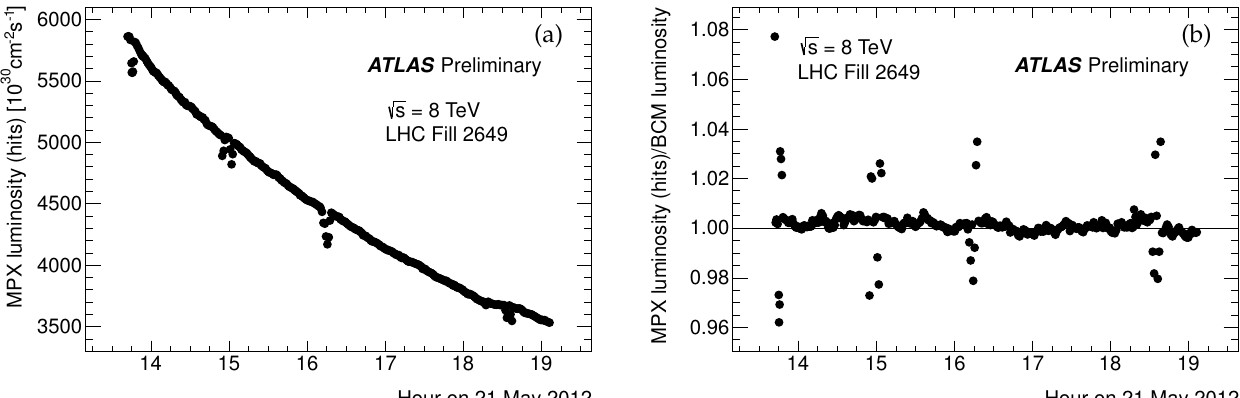
Figure 21. Time history of ( a ) the MPX luminosity and ( b ) the MPX/BCM luminosity ratio. The small luminosity dips apparent in ( a ) and the associated outliers in ( b ) correspond to times when the LHC operators perform small-amplitude beam-separation scans to optimize the luminosity. During these brief intervals, the luminosity varies more rapidly than can be sampled by the online luminosity and MPX data-taking infrastructure, resulting in unphysical variations in the apparent MPX/BCM luminosity ratio. Taken from Ref.